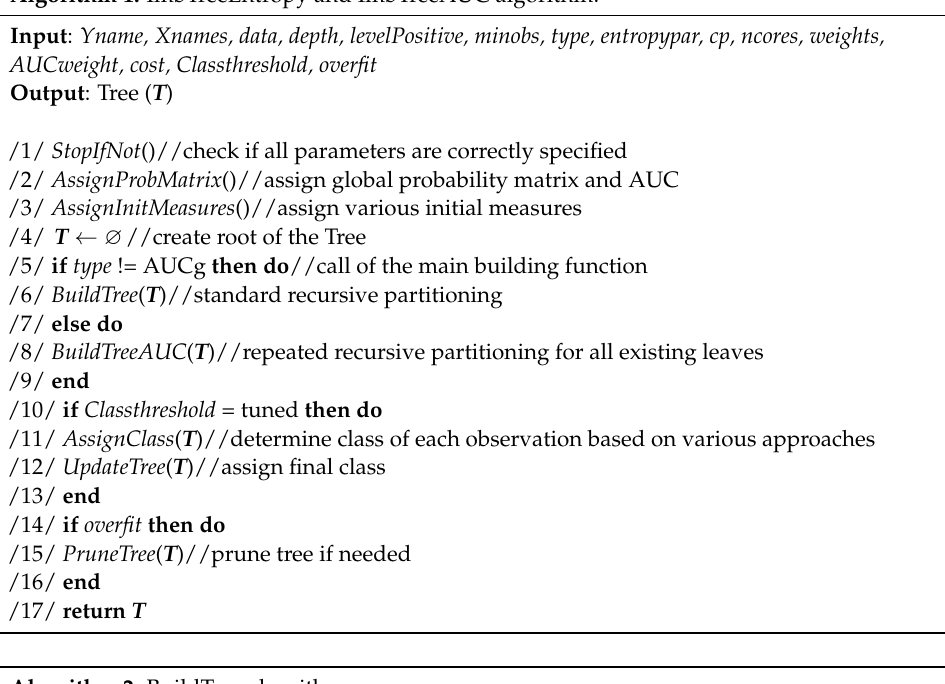
Algorithm 1. ImbTreeEntropy and ImbTreeAUC algorithm.